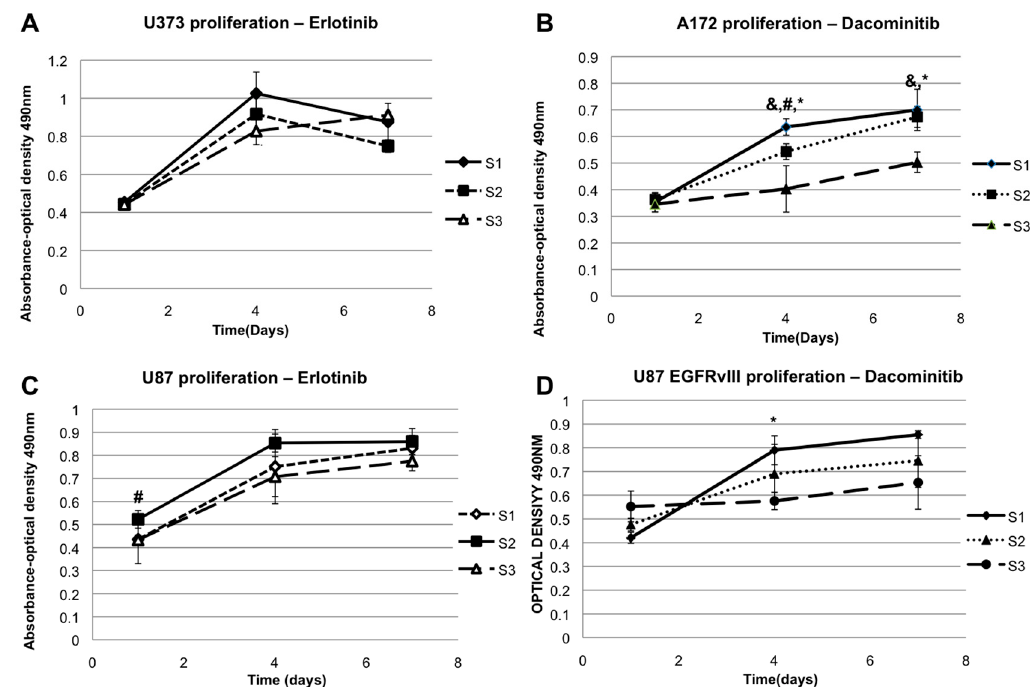
Figure 4. Proliferation of GBM cell types on varying elastic moduli under inhibition of epidermal growth factor receptor (EGFR) inhibitors: U373 cells with erlotinib ( A ), A172 cells with dacomitinib ( B ), U87 with erlotinib ( C ) and U87 EGFRvIII cells with dacomitinib ( D ). * denotes p -value was less than 0.05 when S1 and S3 values were compared, & denotes p -value was less than 0.05 when values of S2 and S3 were compared, and # denotes when p -value was less than 0.05 when S1 and S2 values were compared.